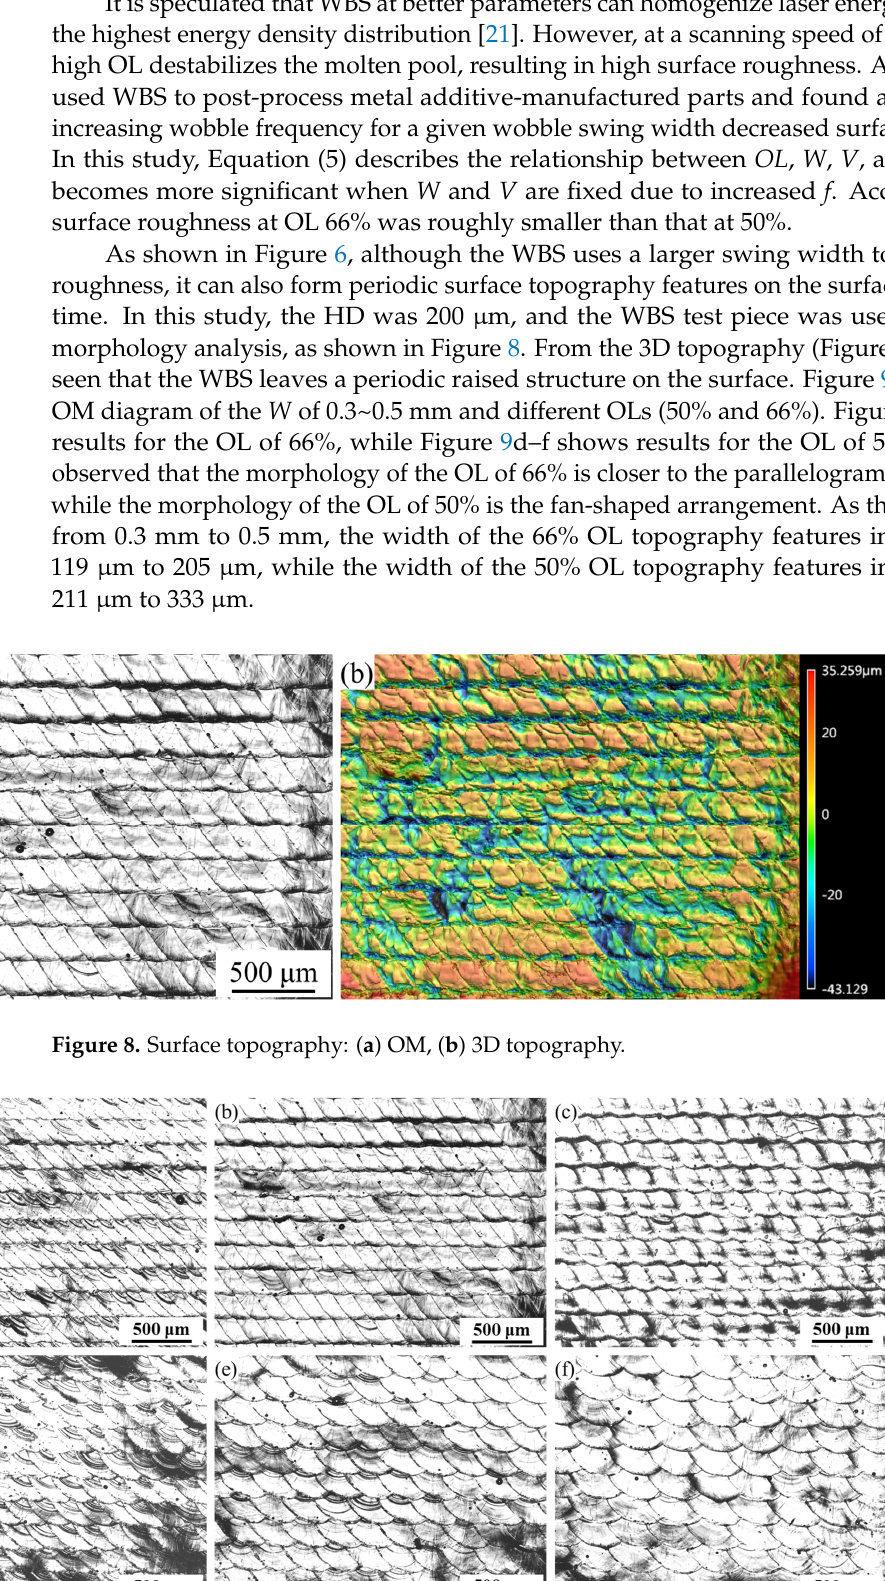
Figure 7. Surface roughness of WBS at different swing overlap ratios and scanning speeds.